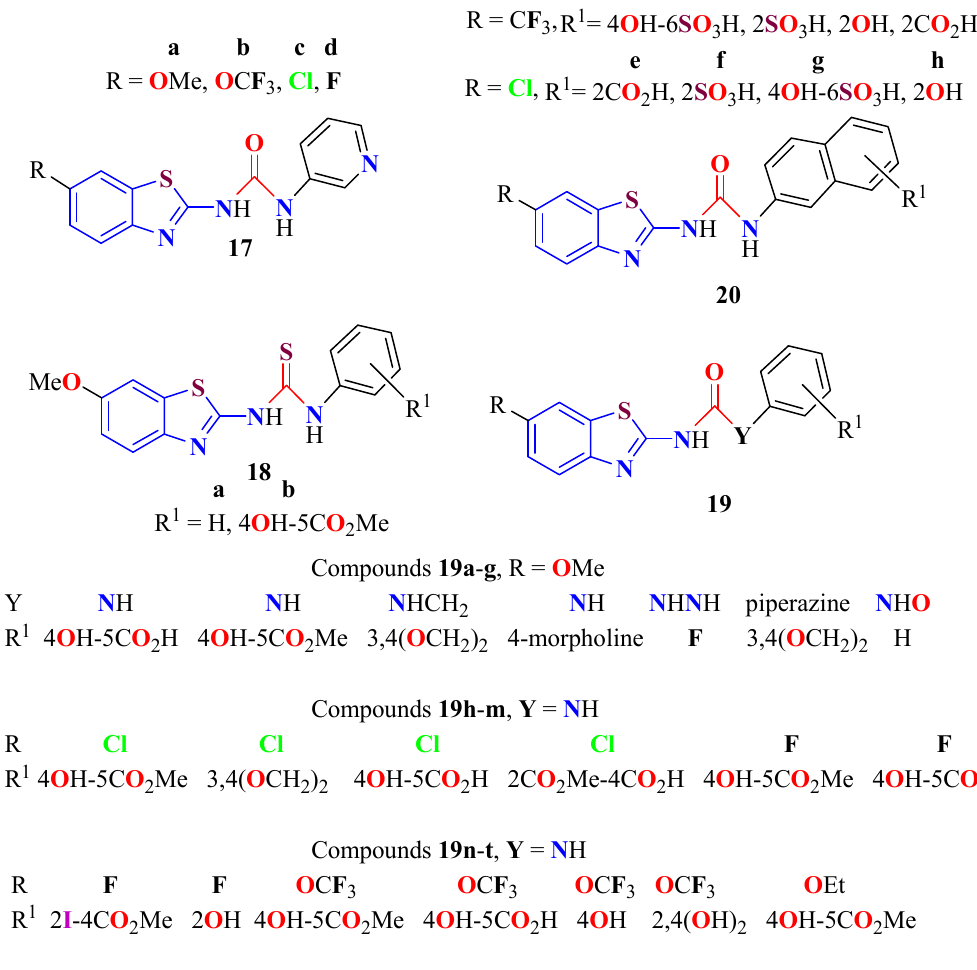
Figure 3. Use of CDI or TCDI to afford substituted-aryl-UBTs 17 , 19 , 20 and -aryl-TBTs 18 . The phenyl-TBT 21 has been isolated from thermal transformation of 3-phenylamino- 5-phenylimino-1,2,4-dithiazole via intramolecular rearrangement through intermediate A , Scheme 8 [126]. Analogous thermal or acidic catalyzed rearrangements have been de- scribed [127].